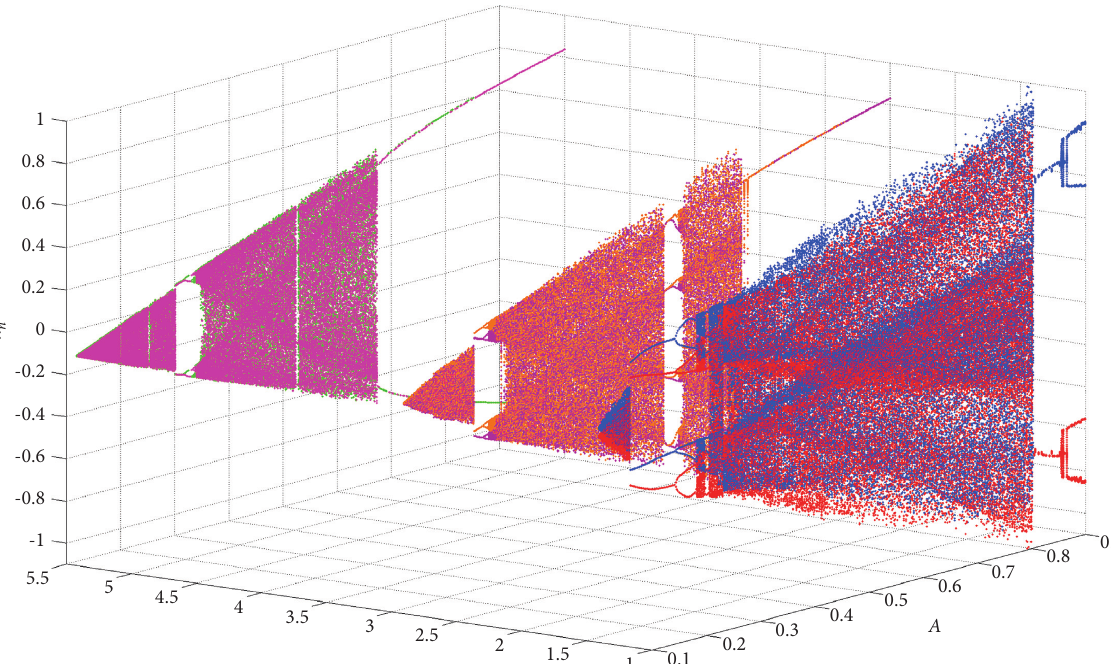
Figure 4: Different bifurcation diagrams of the fractional map (8) in three-dimensional space with the variation of system parameter A , and for two initial conditions: blue diagram for μ � 0 . 2 and for initial condition x brown and green diagram for order μ � 0 . 6; magenta diagram for order μ �